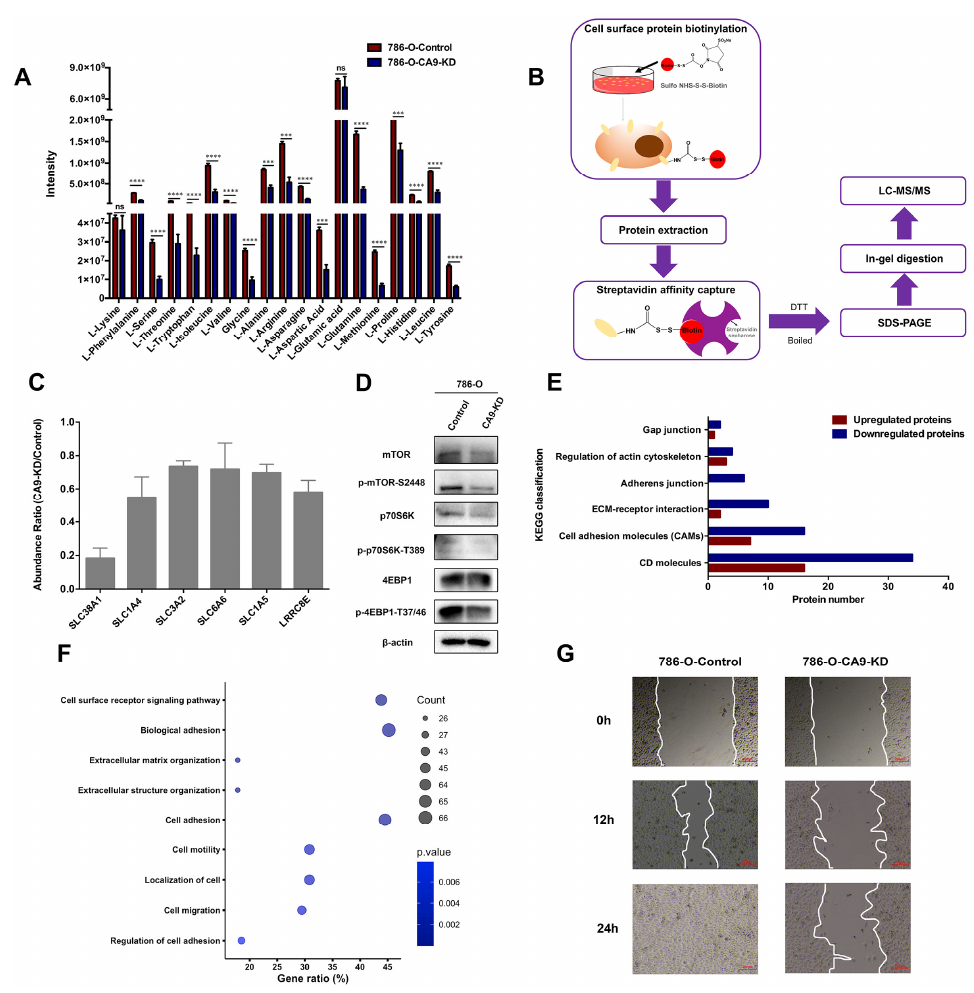
Figure 5. CA9 silencing downregulated expressions of amino acid transporters and proteins associated with cell motility in ccRCC cells. ( A ) Abundance of amino acids in 786-O-CA9-KD cells and control cells. Most amino acids were reduced in CA9 knockdown cells (**** p < 0.0001, *** p < 0.001, ns: no significance; n = 5, mean ± SEM). ( B ) Experimental design for the surfaceomics analysis. ( C ) Six amino acid transporters were downregulated in CA9 knockdown cells ( n = 3, mean ± SEM). ( D ) mammalian target of rapamycin (mTOR) pathway was inactivated in CA9 knockdown cells, assessed by Western blotting of phosphor-mTOR (Ser2448), phospho-p70S6K (Thr389), and phospho-4EBP1 (Thr37/46). β-actin was used as a control. ( E ) Numbers of upregulated and downregulated surface proteins involved in cell motility. ( F ) The downregulated surface proteins in CA9 knockdown cells analyzed by Gene Ontology with DAVID 6.8. ( G ) Cell migration was inhibited in 786-O-CA9-KD cells compared with that in control cells, assessed by the wound healing assay. Cells were imaged at 0, 12, and 24 h after scratching. Scale bar: 200 μm.